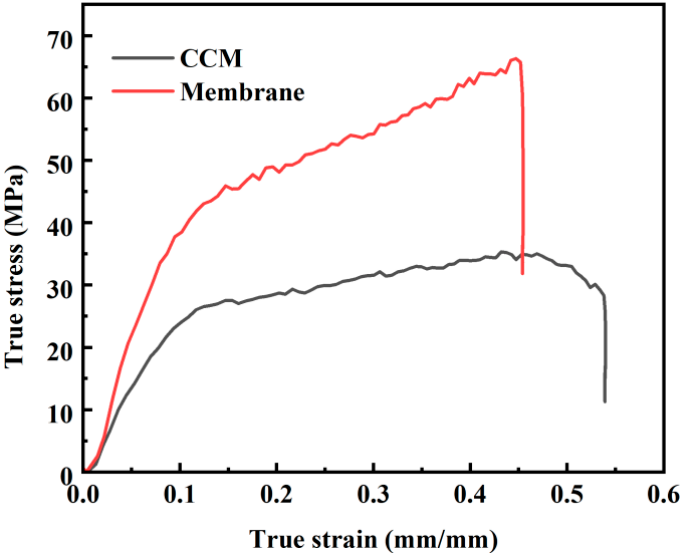
Figure 2. True stress–true strain curves of CCM and membranes at 5/min tensile rate.